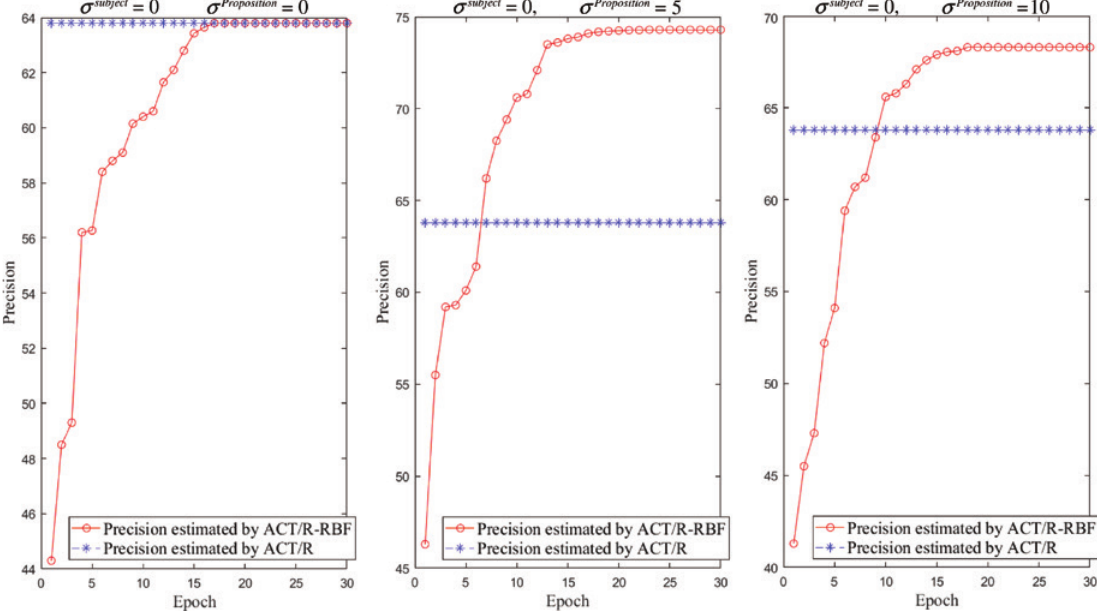
Figure 5: Comparison of the Precision of ACT/R and Hybrid ACT/R-RBF Decision-Making Model for σ Subject = 0.